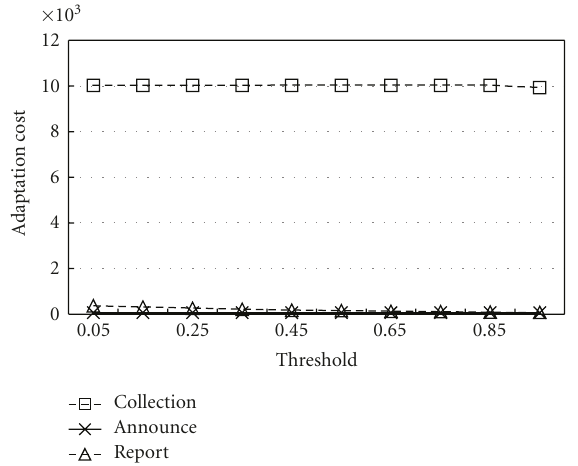
Figure 11: The adaptation cost analysis.